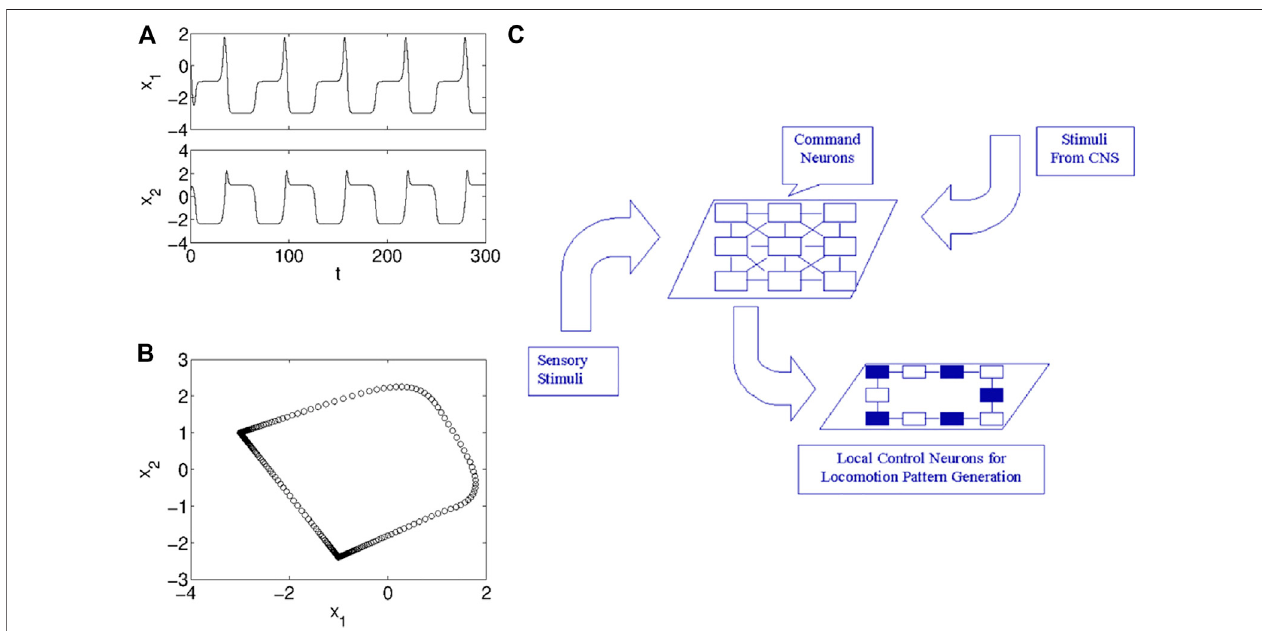
FIGURE 3 | The Central Pattern Generator realized via CNNs. Dynamical behavior of the model (7): (A) temporal trend of the two state variables of a cell, and (B) trajectory of a cell in the phase plane. (C) Schematic representation of the Central Pattern Generator, which is divided into an ensemble of local neurons controlling the actuators of the locomotion pattern, and an ensemble of command neurons selecting the locomotion pattern to implement, on the basis of stimuli from higher neuronal centers or of sensor feedback.